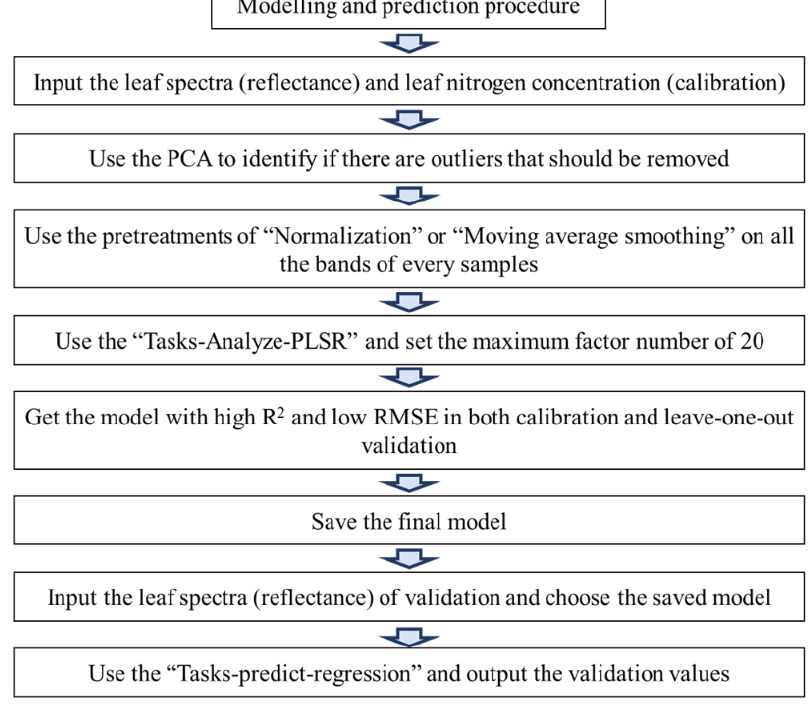
Figure 1. Diagram for the modeling procedure. Table 1. Nitrogen application rates (g · plant − 1 ) for different